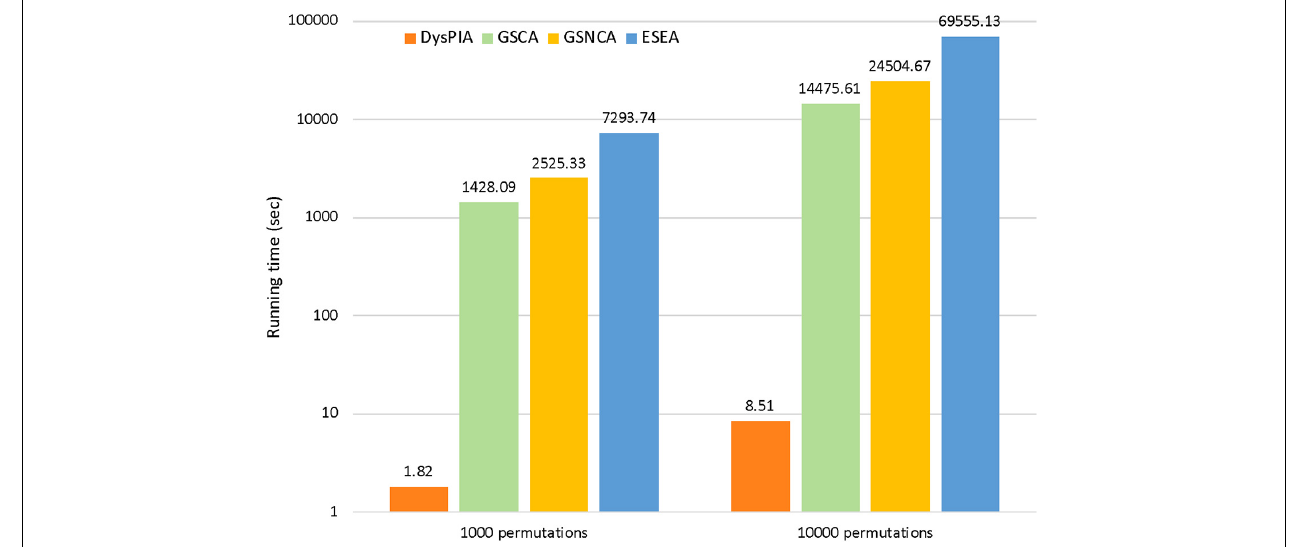
FIGURE 4 | The running time comparison of the four